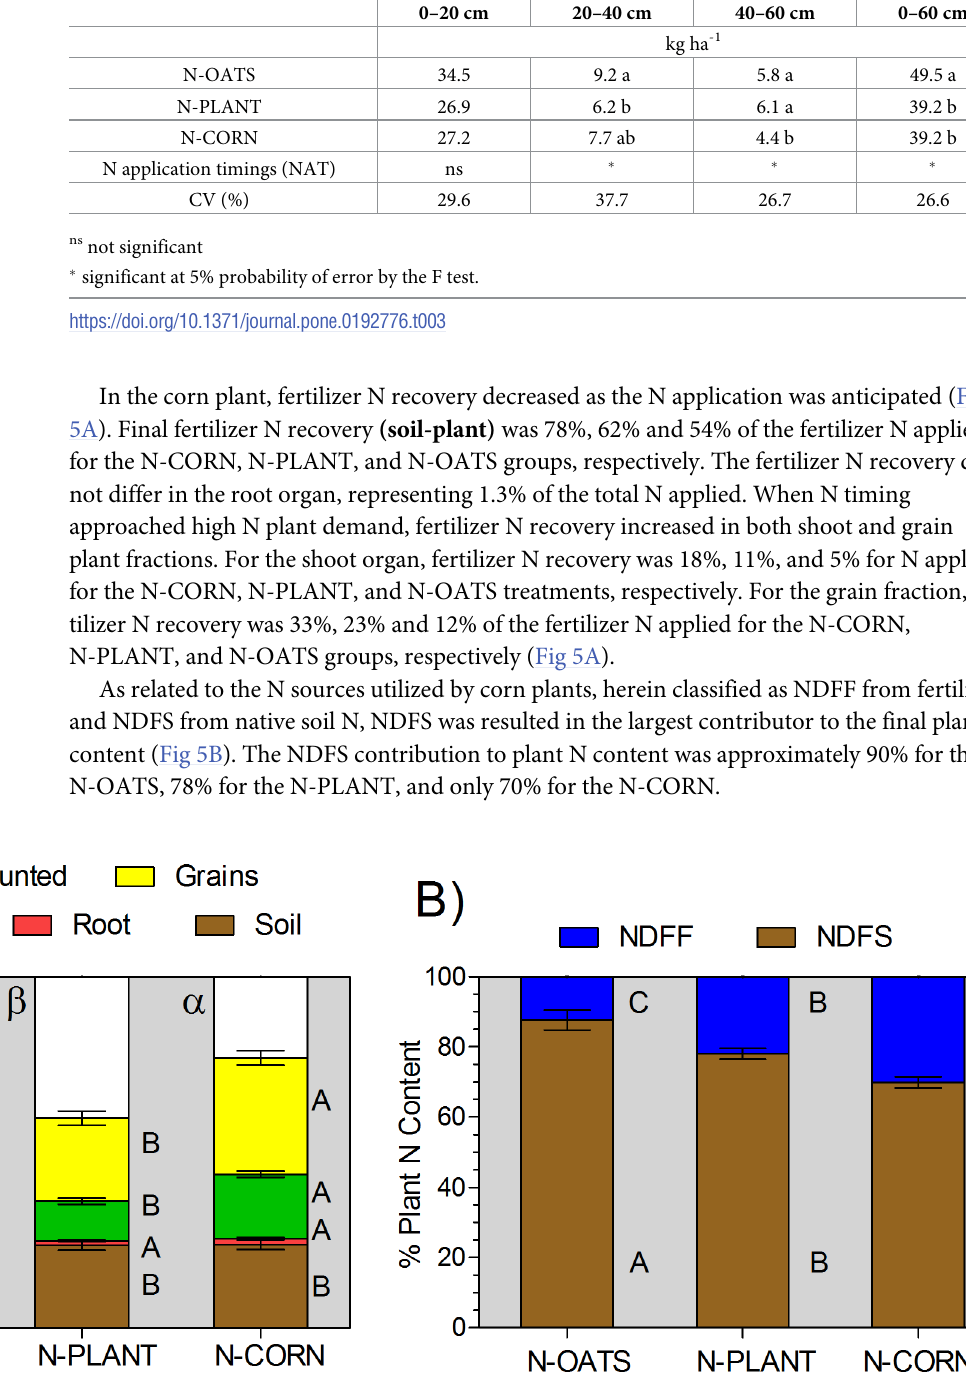
Table 3. Distribution of N derived from fertilizer (NDFF) at corn harvest at varying soil depths from 0–20 cm, 20–40 cm, 40–60 cm, and overall 0–60 cm. Treatment